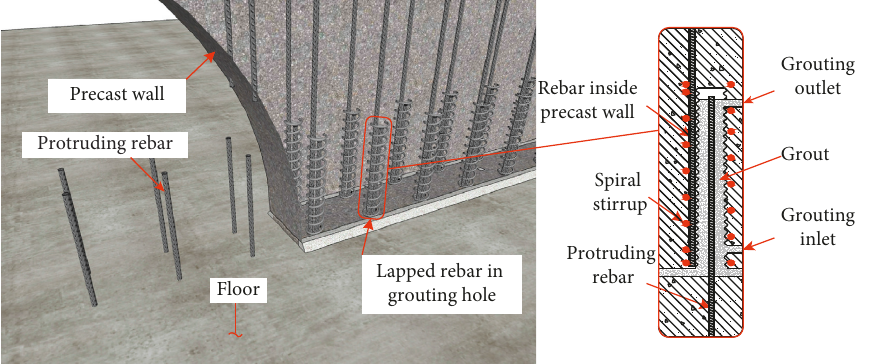
Figure 1: Reinforced mortar anchor lap connection.